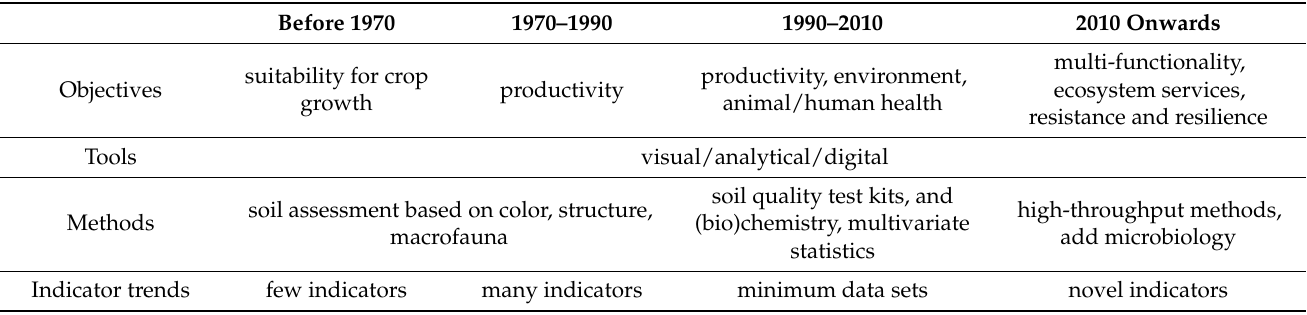
Table 3. Evolution of soil function assessment over time in terms of objectives, tools, methods, and indicators. Before